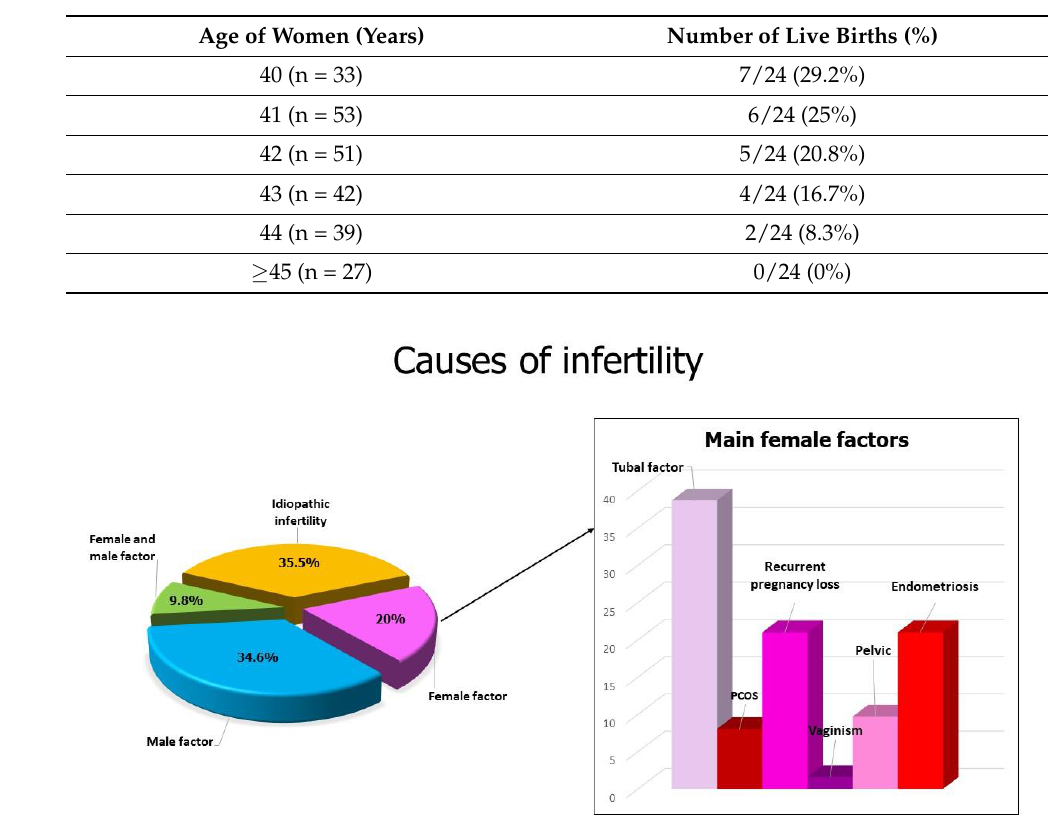
Table 4. Live birth rates based on the woman ’ s age and the number of cases (n).